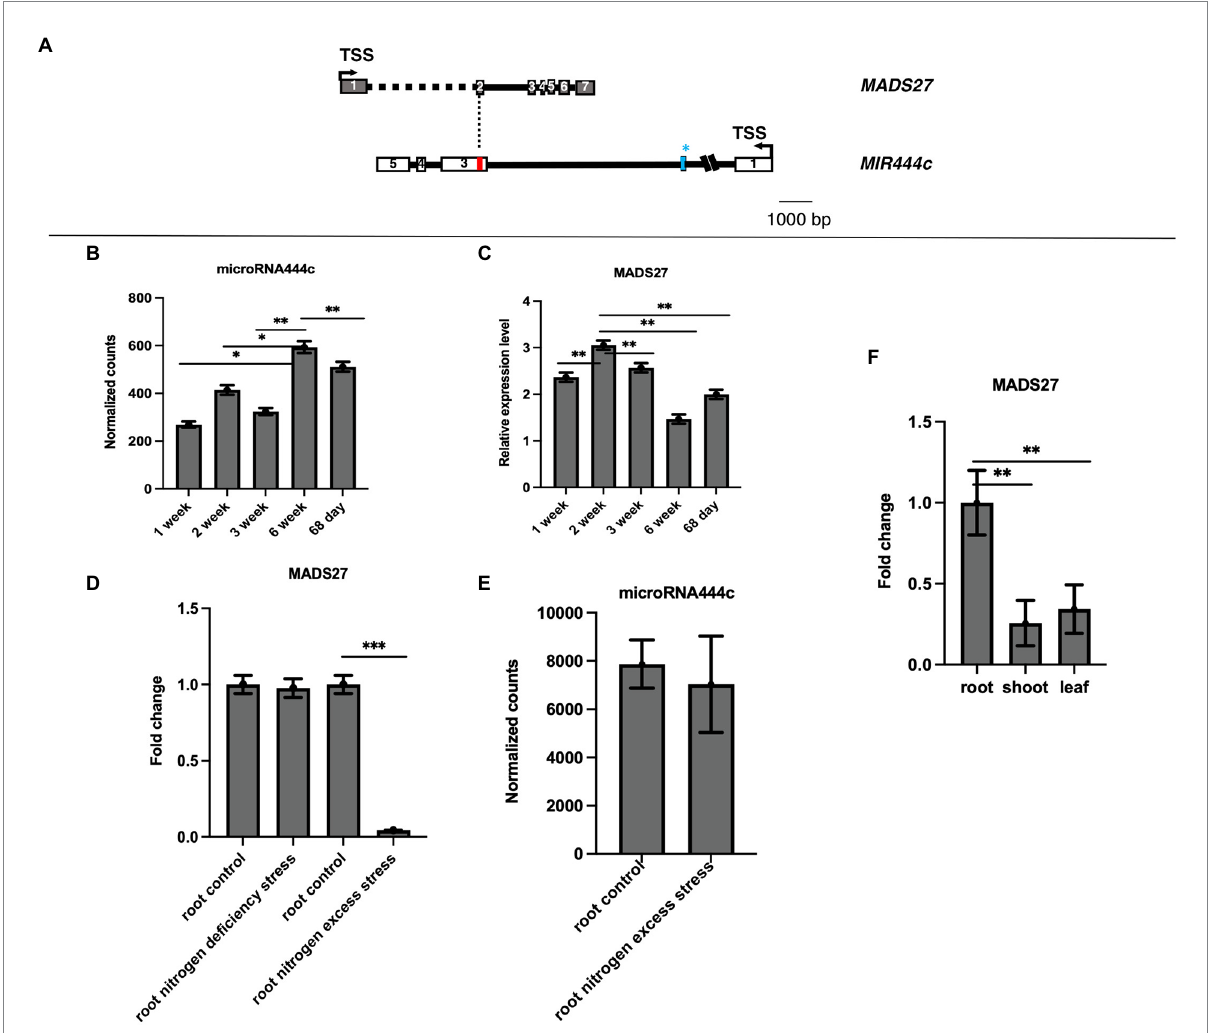
FIGURE 1 Gene structure and expression pattern of HvMADS27 and HvmiRNA444c . (A) HvMADS27 and MIR444c gene structures based on the 5 ′ and 3 ′ RACE analysis. White and gray blocks represent exons and black lines introns, blue bar in the secondexon of MIR444c gene represents miRNA444c ✶ and red bar in the third exon represents miRNA444c, while dotted line marks overlap between two genes. (B) Results of deep sequencing of sRNA libraries, where the x -axis represents barley developmental stages and y -axis normalized counts. Mature miRNA444c occurred at the highest expression in sixth week of development. (C) HvMADS27 mRNA relative to ARF 1 mRNA level (Gene Bank: AJ508228.2) expression in barley at different developmental stages, with the x -axis representing developmental stages and y-axis expression of HvMADS27 . The highest expression was observed at the second week of barley development. (D) RT-qPCR data showing HvMADS27 expression in the roots of 2-week-old barley under N scarcity and excess N stress. There was a significant downregulation in HvMADS27 expression under excess N stress, but no change was observed under N scarcity. (E) Level of mature miRNA444c based on deep sequencing of sRNA analysis in roots of plants grown under control and excess N conditions. No change was observed in the expression level of mature miRNA444c under excess N stress conditions compared with the control. p value based on Bonferroni correction was used. (F) RT-qPCR results showing that HvMADS27 is mainly expressed in the roots of 2-week-old barley plants. (D) Student’s t -test was applied; * p < 0.05, ** p < 0.01, *** p <